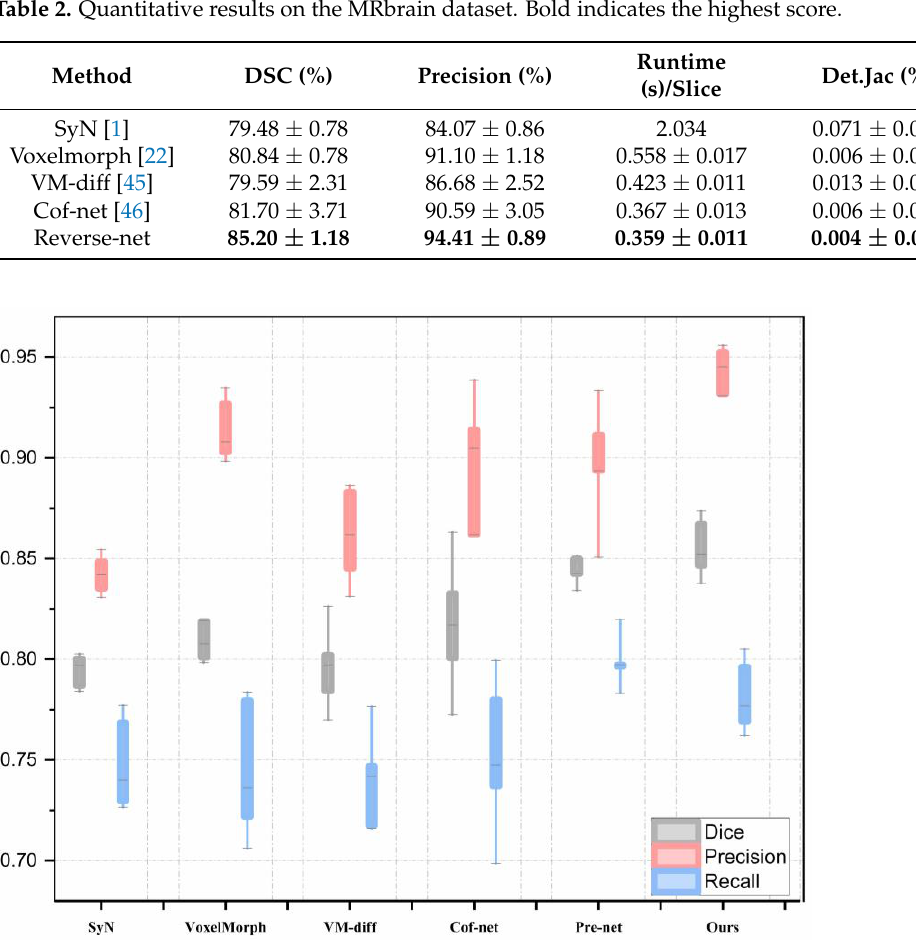
Figure 9. Boxplots of the results of different methods on the MRbrain dataset. Figure 10 shows the visualization of the images from the perspective of axial slices. The columns marked with W indicate the warped images. ϕ indicates the deformation field visualization figure. The red color in the visualized image indicates the horizontal transformation and the green color indicates the vertical transformation. The higher the red or green signal, the larger the transformation. As shown in Figure 10, typical registration results from the MRbrain dataset show that the warped image generated by our method is most like the fixed image; our method can achieve the better registration among several